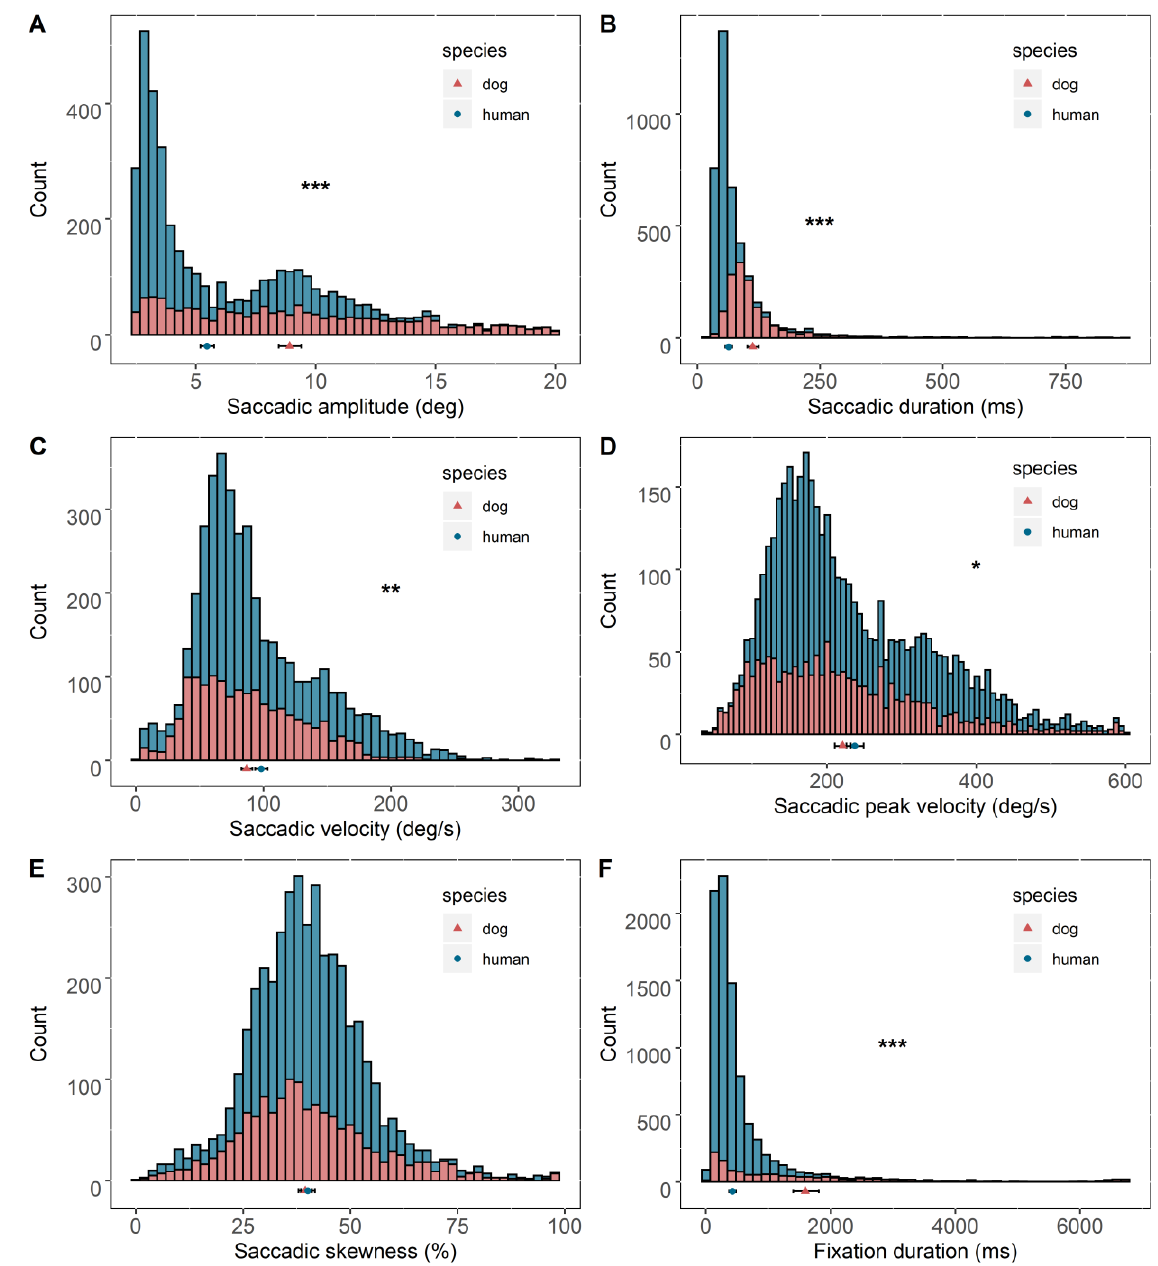
Figure 4. Comparison of saccadic and fixation metrics between humans and dogs. Histograms visualize distribution patterns of human and dog saccades or fixations. Solid shapes and error bars depict marginal means and 95% confidence intervals (+/−1.96 ∗ SE), re- spectively. Significance codes: ‘***’ < 0.001 < ‘**’ < 0.01 < ‘*’ <